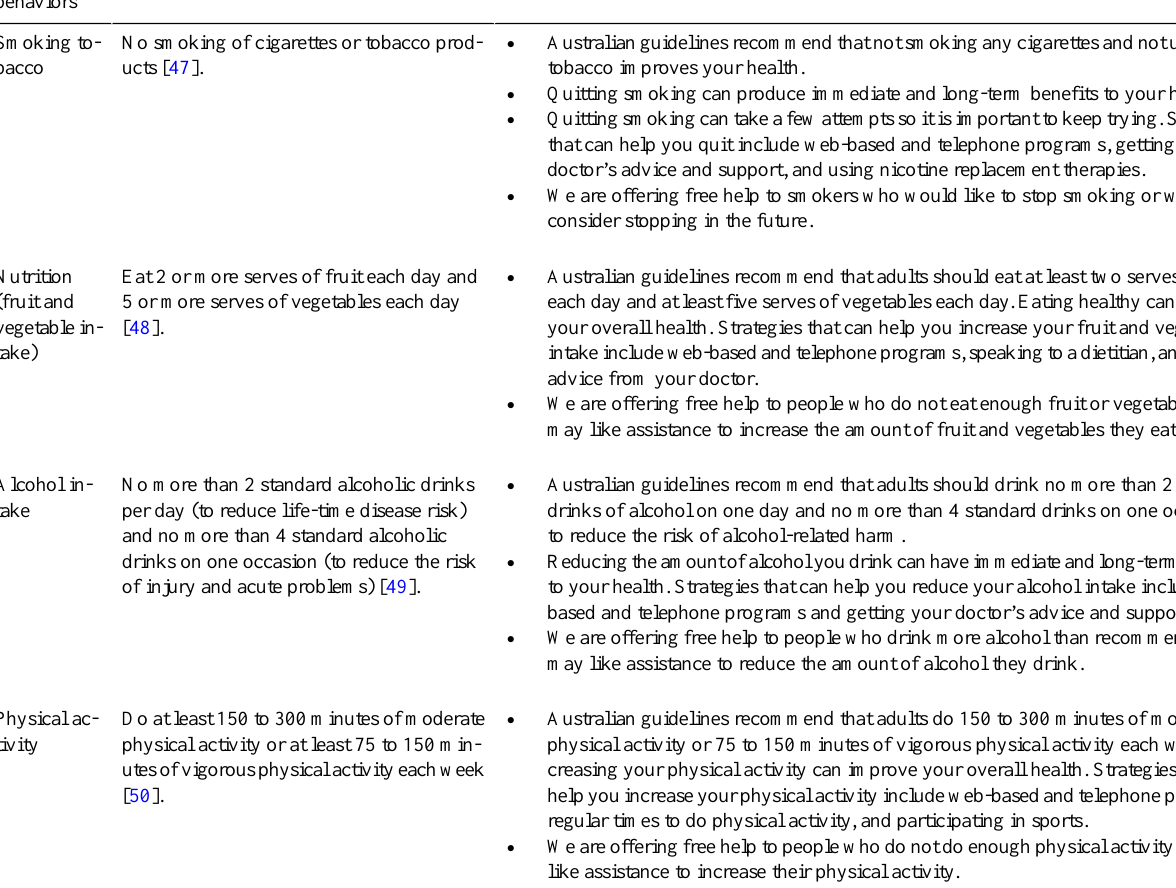
Electronic feedbackAustralian health guidelinesHealth risk